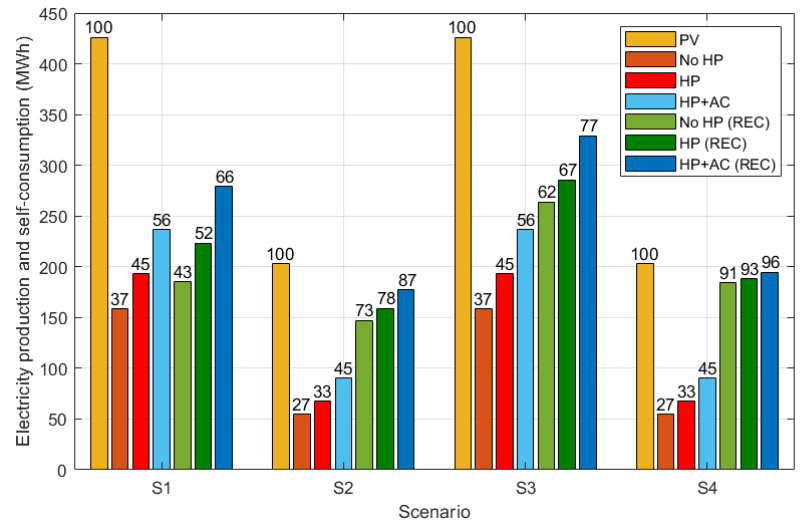
Figure 6. Electricity produced and self-consumed in different scenarios.